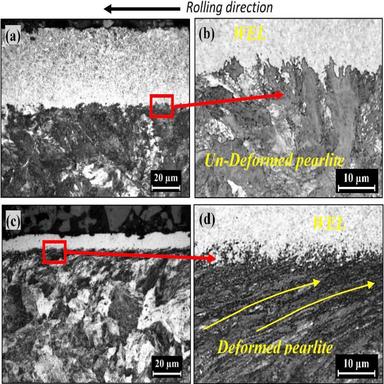
Reflected light micrographs of White Etching Layer of (a) rail sample A and (b) its corresponding enlarged image showing undeformed pearlite structure at transition zone; (c) rail sample B and (d) its corresponding enlarged image showing deformed pearlite structure at transition zone.